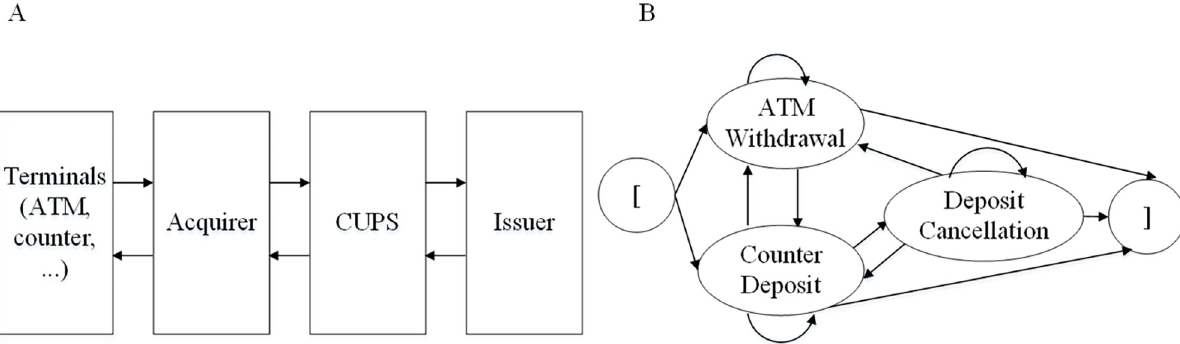
PLOS ONE | https://doi.org/10.1371/journal.pone.0212476 February 19,